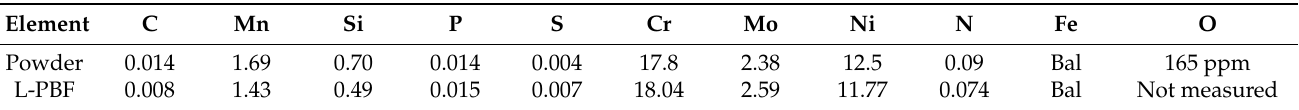
Table 1. Chemical compositions of 316 L stainless steel powder precursor and 316 L stainless steel bars processed with L-PBF (wt